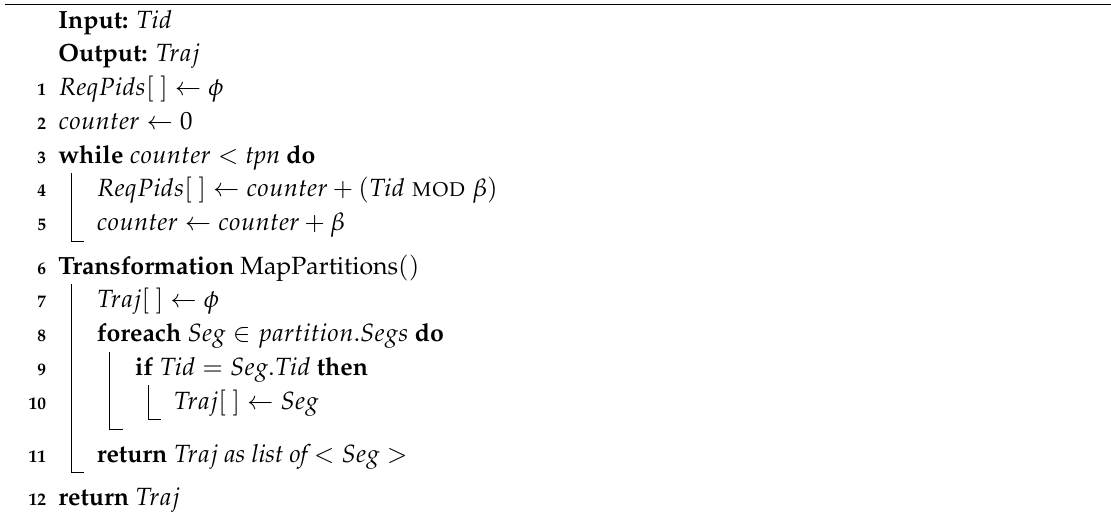
Algorithm 3: RMOI: Processing Lookup